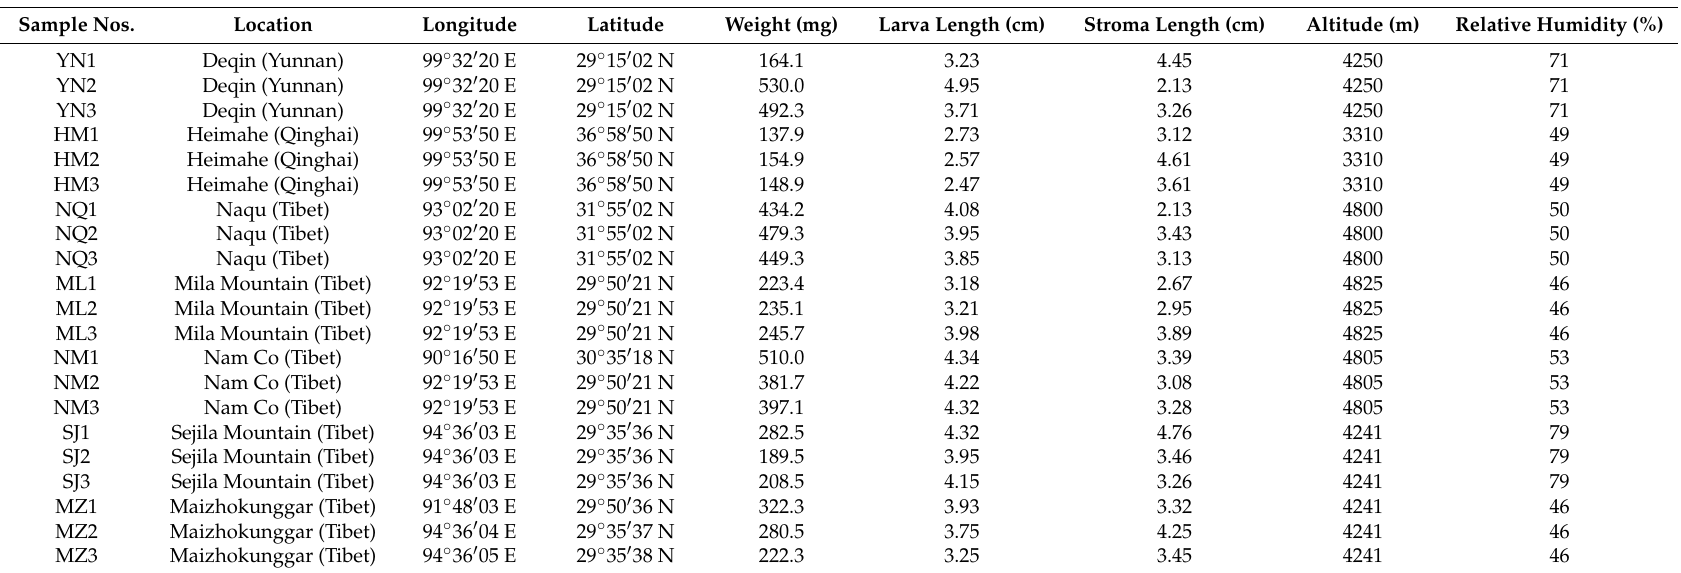
Table 1. Description of twenty-one samples of Ophiocordyceps sinensis from Yunnan, Qinghai and Tibet, China. Sample